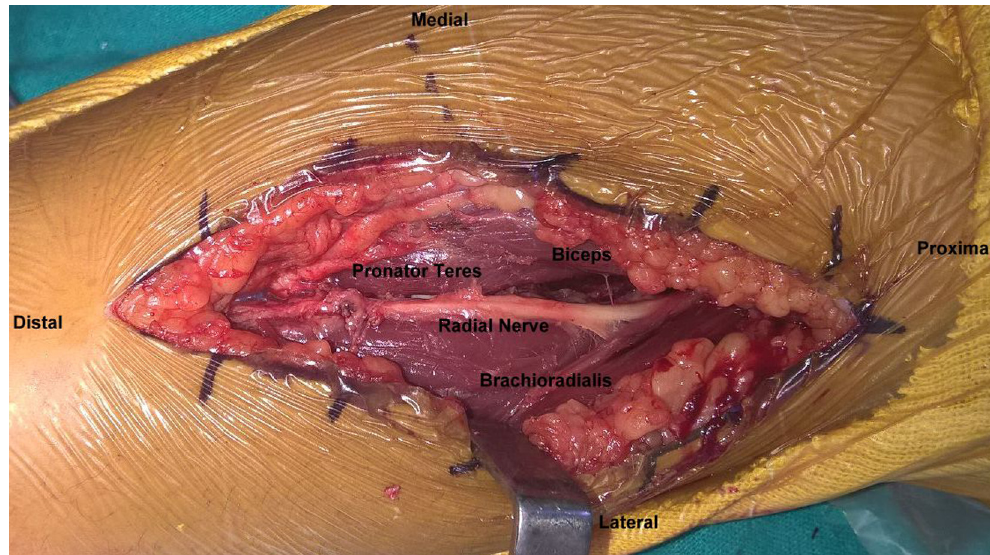
Figure 5. The deep dissection planes and the isolation of radial